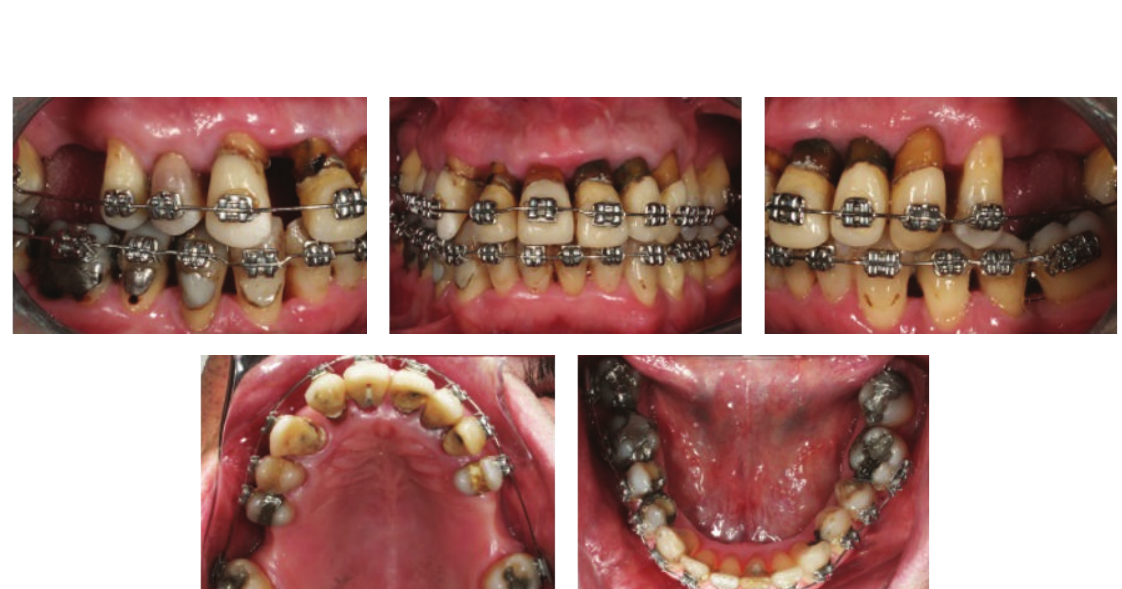
Figure 3: Periodontal treatment.